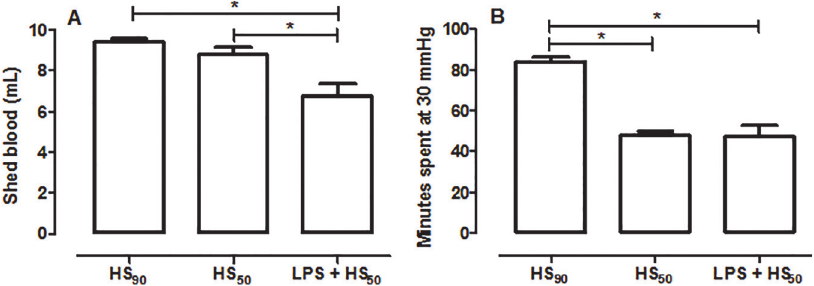
Fig 2. Effect of LPS preconditioning on shed blood and period of time spent at 30 mmHg. Rats were injected vehicle (PBS) or LPS (1 mg/kg) i.p. 24 h prior to HS 90 or HS 50 . The shed blood (A) and the period of time that animals spent at 30 mmHg (B) are shown. Data are expressed as mean ± SEM of 8 – 10 animals. Statistical analysis was performed using one-way ANOVA followed by Bonferroni ’ s post hoc test. * p < 0.05 among the groups.